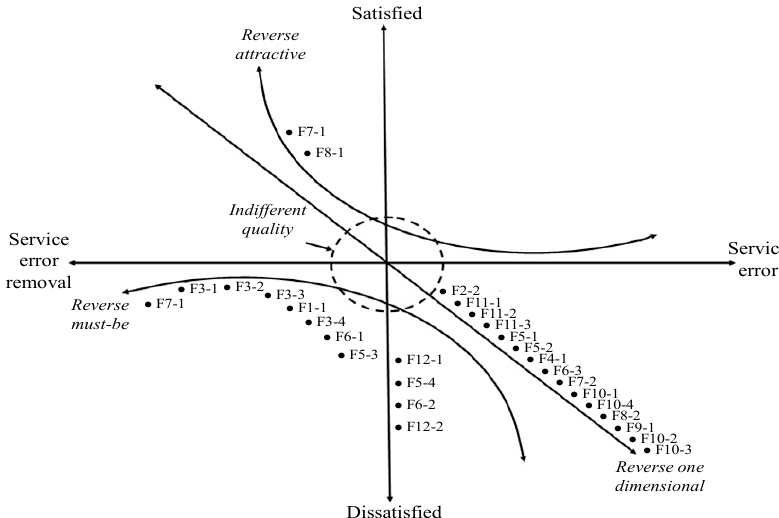
Figure 2. Classification of the Kano two-dimensional quality factors.